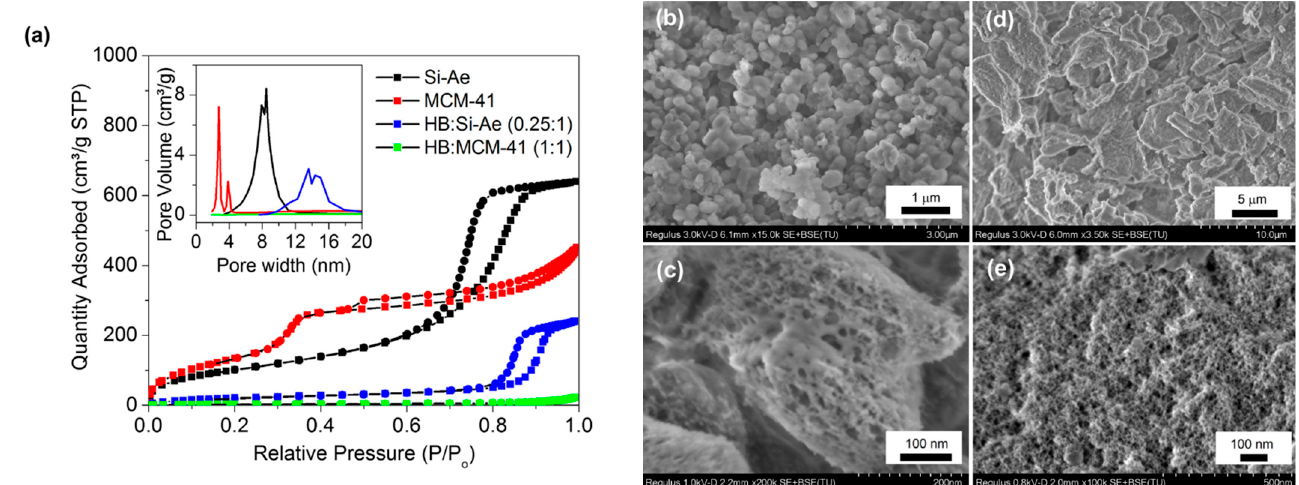
Figure 3. ( a ) Nitrogen adsorption-desorption isotherms and BJH pore size distribution (inset) of MCM-41, silica aerogel, HB:MCM-41 (1:1) and HB:Si-Ae (0.25:1). Solid cubes ( (cid:4) ) and spheres ( • ) denote adsorption and desorption, respectively. ( b , c ) SEM images of MCM-41 at 15 k and 200 k magnification, respectively. ( d , e ) SEM images of silica aerogel at 3.5 k and 100 k magnification, respectively.